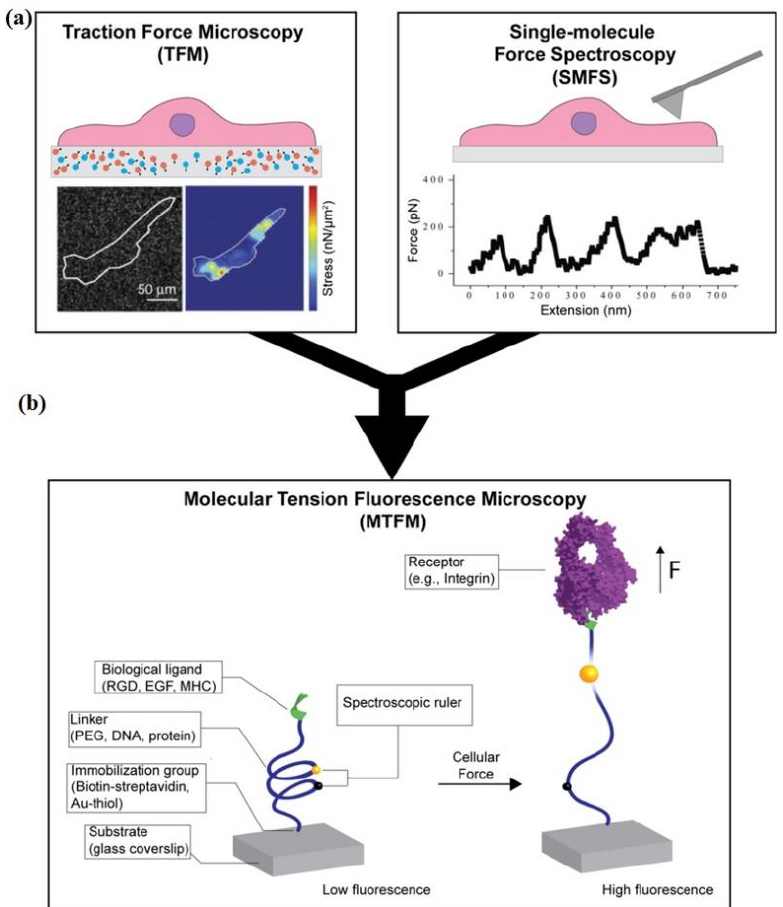
Figure 15. Schematic of current technologies to image cell forces. ( a ) Scheme depicting traction force microscopy (TFM) and single-molecule force spectroscopy (SMFS). ( b ) Simplified diagram that shows how tension probes report on cell forces. (RGD–Arginine-glycine-aspartic; EGF–Epidermal growth factor; MHC–Major histocompatibility complex) (Reproduced with permission from [198]).